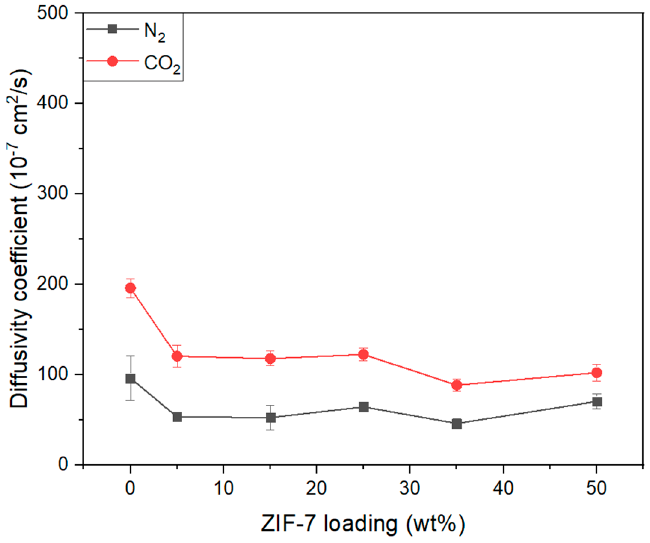
Figure 16. CO 2 and N 2 diffusivity coefficient of Pebax ‐ 2533/ZIF ‐ 7 composite membranes.